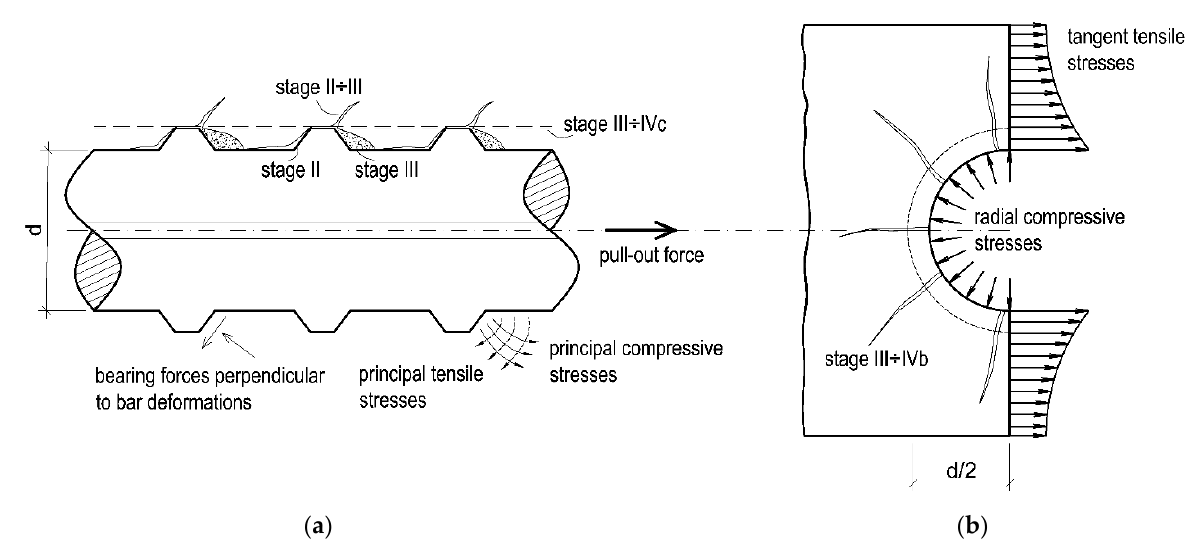
Figure 2. Cracking and damage mechanisms during bond action: ( a ) phenomena in the vicinity of the ribs, ( b ) cross-sectional view between ribs of reinforcement.